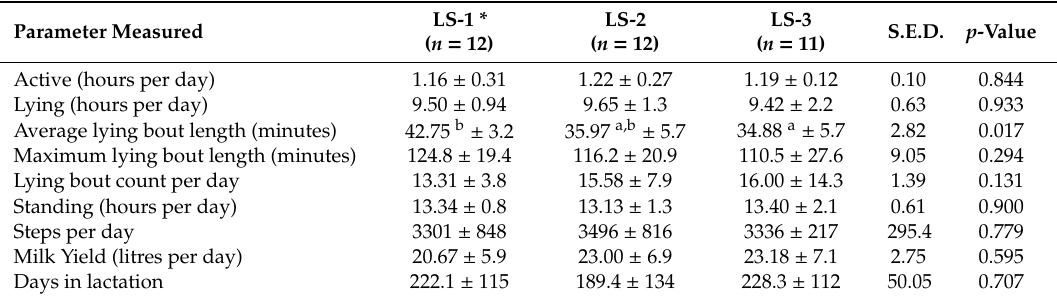
Table 2. The e ff ects of locomotion score (LS) on the standing, lying and active behaviour and milk production of straw housed zero-grazed lactating Jersey dairy cattle. Mean ± SD presented in each column, overall standard error of di ff erence (S.E.D.) also presented. LS-1 represents cows with acceptable mobility, LS-2 cows with impaired mobility and LS-3 severely impaired